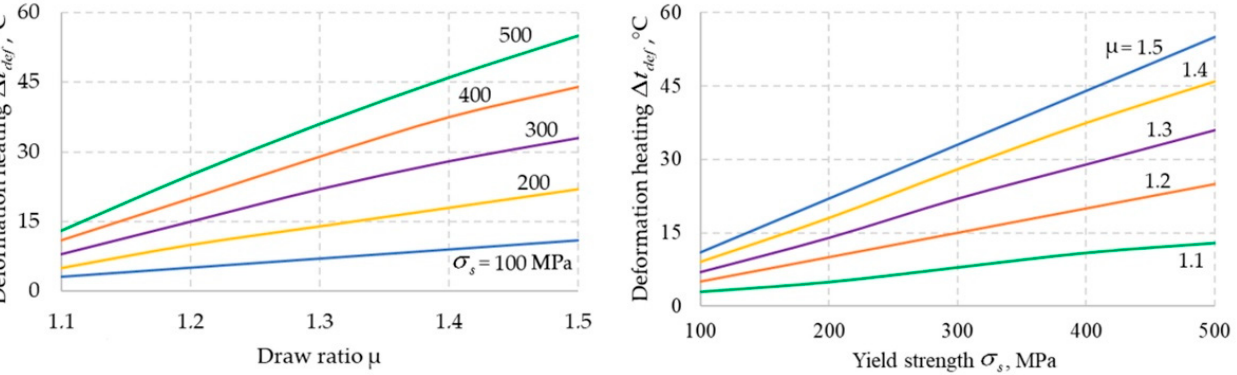
Figure 2. Deformation heating of the steel wire.